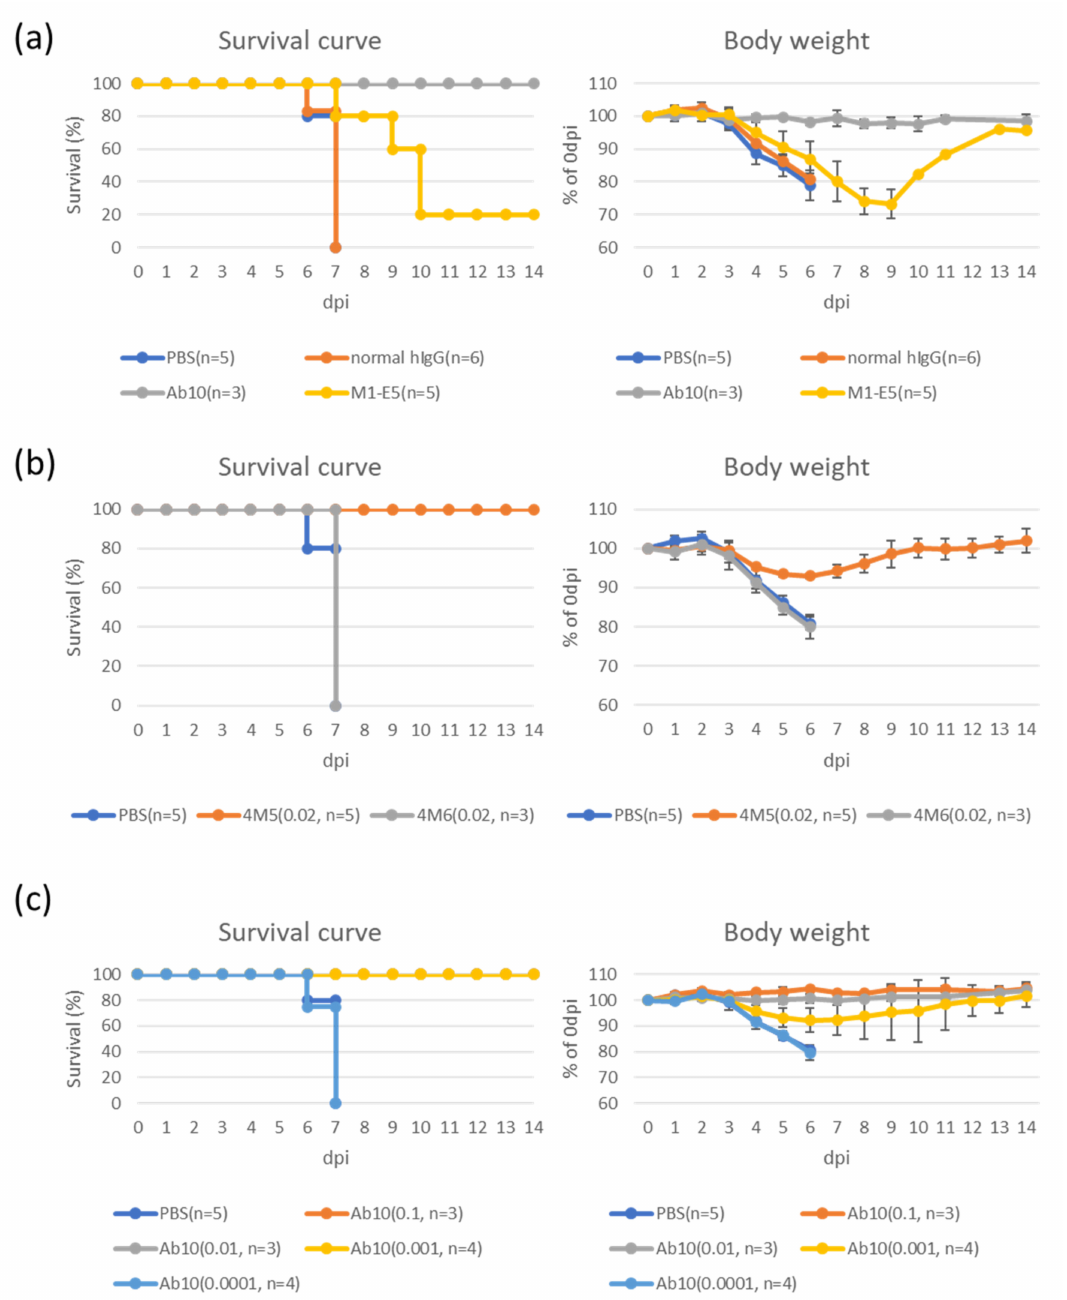
Figure 2. Therapeutic effects of mAbs in a fatal animal model of SFTS. IFNAR -/- mice infected with SFTS virus were intraperitoneally injected with 1 mg ( a ) or indicated doses (mg) in parentheses ( b ) and ( c ) of mAbs daily between 1 dpi and 6 dpi. The parentheses also include numbers of mice used ( a – c ). Mice were observed for their survival/death (left, Kaplan-Meier) and body weight (right) daily up to 14dpi. On the right, body weight percentages against 0 dpi are shown. Data of body weight are shown in means ± standard